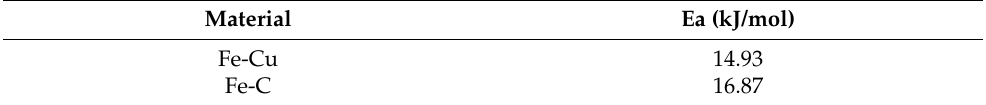
Table 3. Activation energy of CIP removal under Fe-Cu and Fe-C treatment. Material